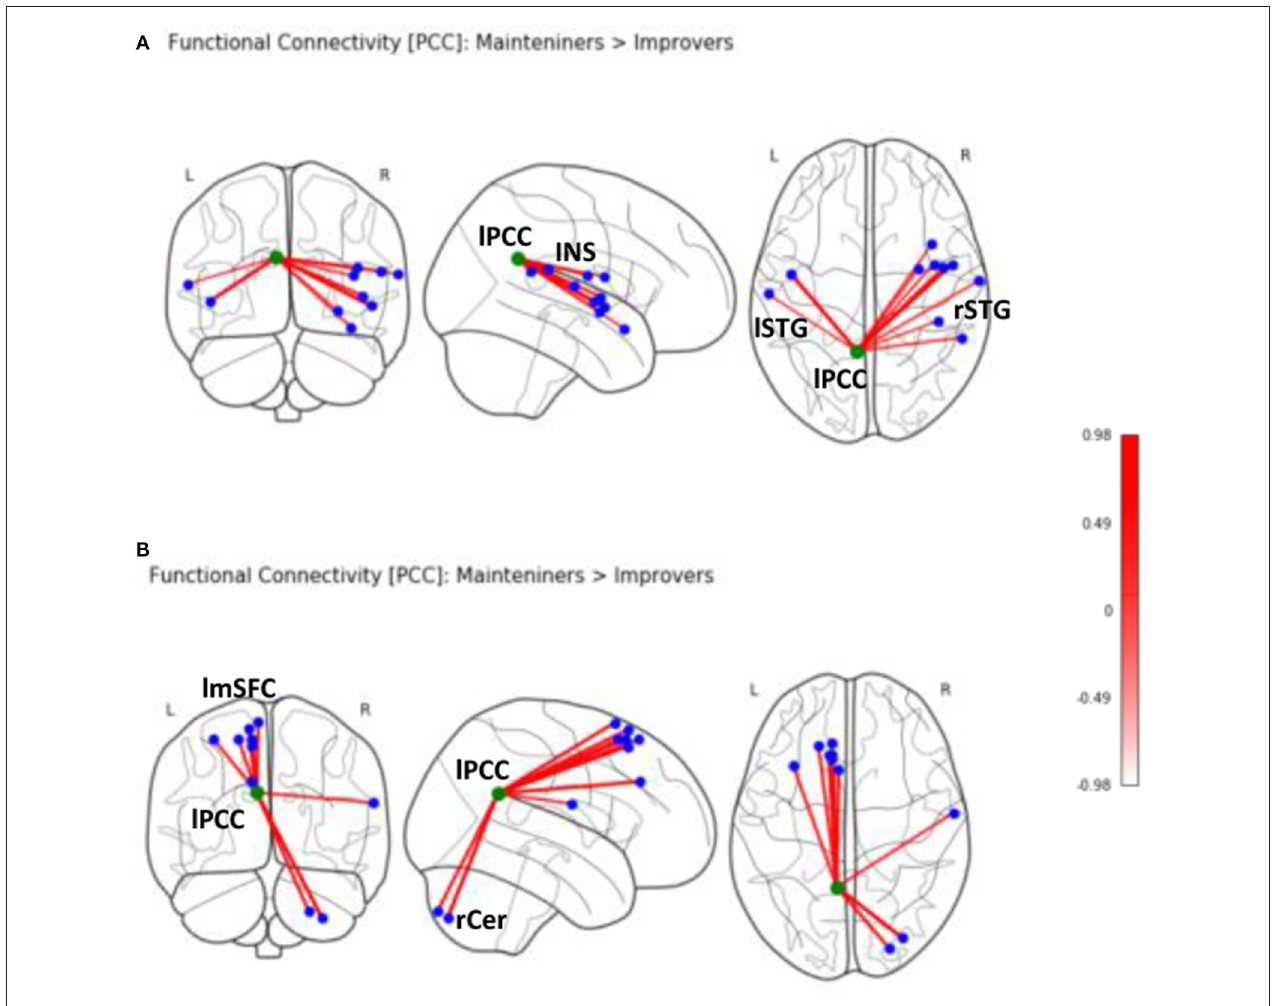
FIGURE 2 | Seed-based rsFC of posterior cingulate (PCC) on MNI schematic template (https://nilearn.github.io) in (A) Maintainers > Improvers (INS, insula; lSTG, left superior temporal gyrus; rSTG, right superior temporal gyrus). (B) Seed-based rsFC of PCC in Improvers > Maintainers (rCer, right cerebellum; lmSFC, left medial superior frontal